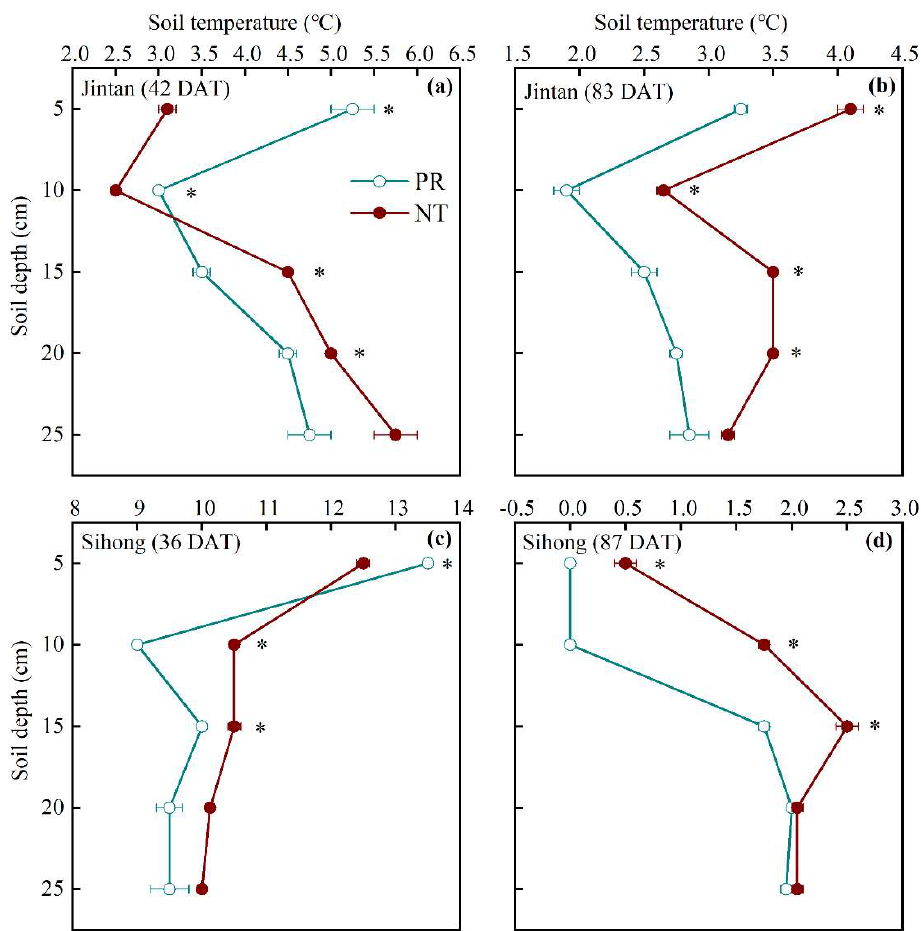
Figure 5. Effects of tillage methods on soil temperature in different depths of soil at the 42nd and 83rd day after tillage at Jintan ( a , b ) and the 36th and 87th day after tillage at Sihong ( c , d ) in 2018–2019. Tillage methods included plow tillage followed by rotary tillage (PR) and no-tillage (NT). All values are presented as mean ± SE (3 replicates) with one standard error. * indicates significant differences among different tillage methods at the p < 0.05 level.